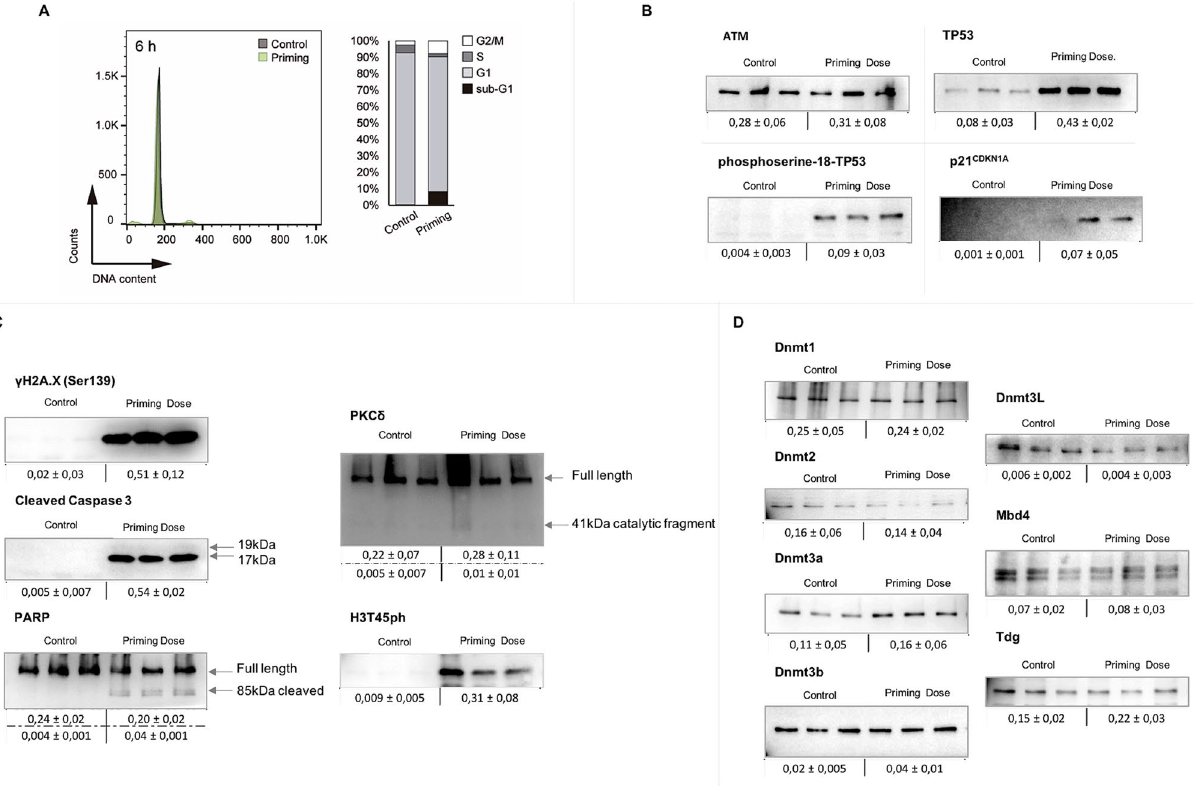
Figure 4. Study of the remnant radiation response 6 h after exposure to the priming dose (0.0075 Gy) in mice in vivo. ( A ) Cell cycle analysis using flow cytometry. Propidium iodide (PI) staining of thymocytes for control cells and thymocytes exposed to the priming dose (0.0075 Gy) 6 h after exposure. Representative plot (left panel) and the mean of 3 biological replicates (right panel). ( B ) Western blot analysis of several proteins of the ATM- TP53-phosphoserine-18-TP53 axis. Expression changes of ataxia telangiectasia mutated protein (ATM); tumor protein p53 (TP53); phosphoserine-18-TP53 and p21 CDKN1A . Blots show 3 biological replicates for each radiation regime. ( C ) Markers of the damage response and cell death pathways were determined by immunoblotting with antibodies specific against γH2AX-Ser139 (15 kDa), Caspase 3 activated subunits (19 and 17 kDa), Poly (ADP-ribose) polymerase-1 (PARP1) full length (116 kDa) and its cleavaged form (89 kDa fragment), PKCδ full length (78 kDa) and its catalytic fragment (41 kDa) and Phosphorylation of H3T45 (H3T45ph) (15 kDa). ( D ) Chromatin remodellers study 6 h after the priming dose. Comparative analysis of the endogenous expression of DNMTs DNMT1 (200 kDa), DNMT2 (55 kDa), DNMT3A (130 kDa), DNMT3B (96 kDa) and DNMT3L (49 kDa) and the glycosylases MBD4 (Methyl Binding Domain) (60–65 kDa) and TDG (Thymine DNA glycosylase) (55–65 kDa) in mouse thymocytes 6 h after the priming dose. β-Actin was probed as a loading control for each membrane in annexed Fig. 4. Original blots are presented in supplementary